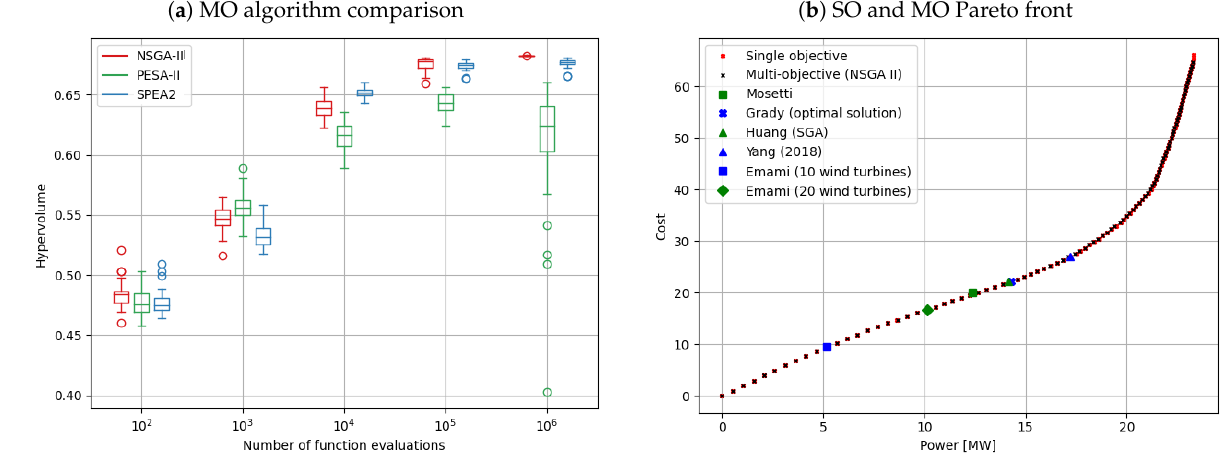
Figure 9. Multi-objective algorithm performance and Pareto front for case 1.